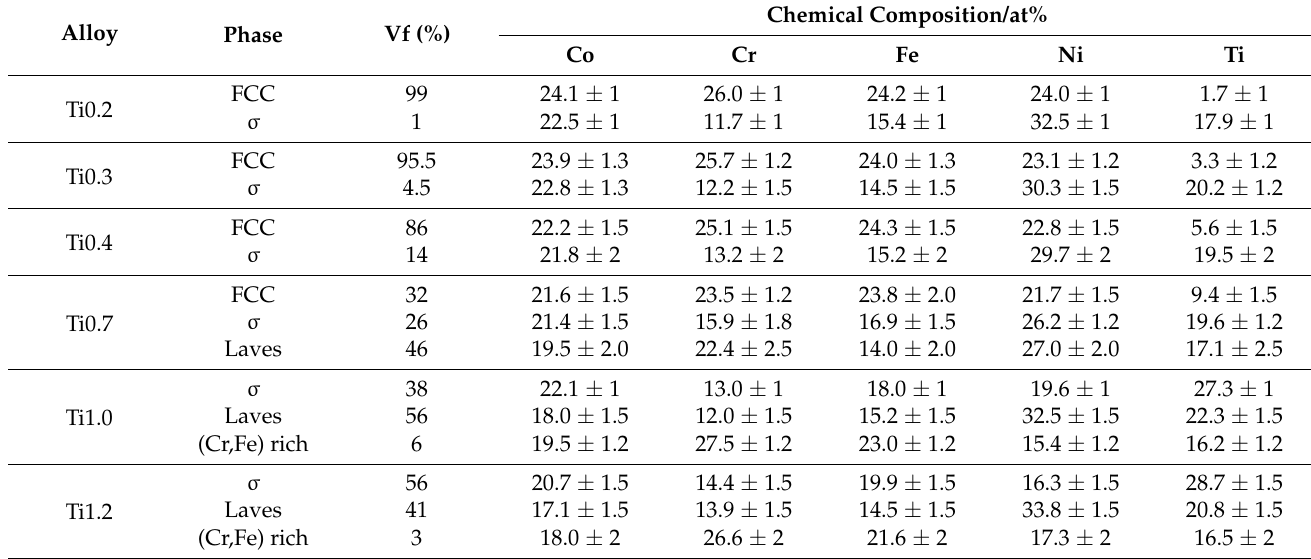
Table 1. Elemental analysis of different regions in as-cast CoCrFeNiTix composites.